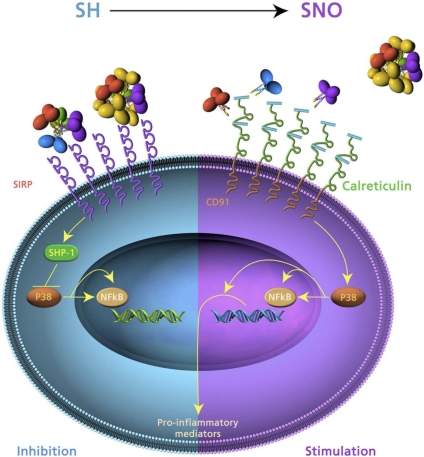
A Model of the Pro- and Anti-Inflammatory Functions of SP-DUnder non-inflammatory conditions, SP-D remains in large multimeric or dodecameric forms in which the tail domains remain buried. The head domains bind to SIRP-1α and activate the kindase SHP-1. SHP-1 activation inhibits p38 activations, potentially resulting in the blockaged of NF-κB action and the inhibition of infammatory function. Under inflammatory conditions the production of NO leads to the formation of SNO-SP-D and the disruption of the multimeric structure. The tail domains now become exposed and bind to calreticulin. This results in p38 phosphorylation via CD91, potentially leading to NF-κB activation and the production of pro-inflammatory mediators. Presumably other actions which result in disruption of SP-D multimeric structure may also be pro-inflammatory.(Image credit: Kirk Moldoff)